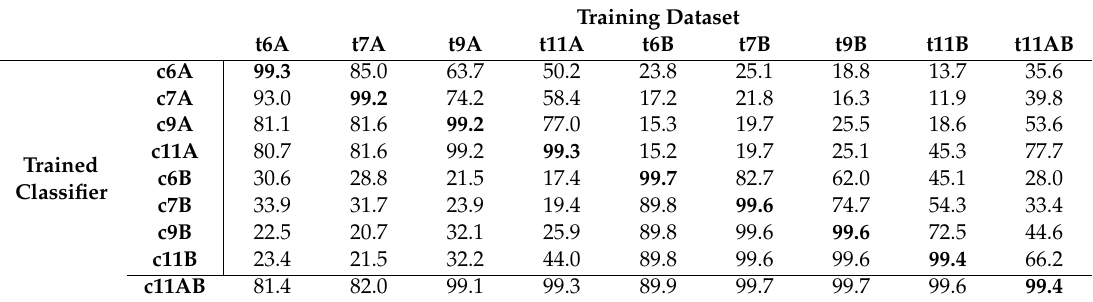
Table 4. Cross-over classification accuracy (reported as a percentage) for Amery and Roi Baudouin ice shelf trained classifiers, using training datasets as validation. Bold text denotes resubstitution accuracy (after the classifier is generated, it is then applied to the original training dataset). The bottom row shows the combination classifier, generated from training data from both ice shelves, which can accurately classify training data from both